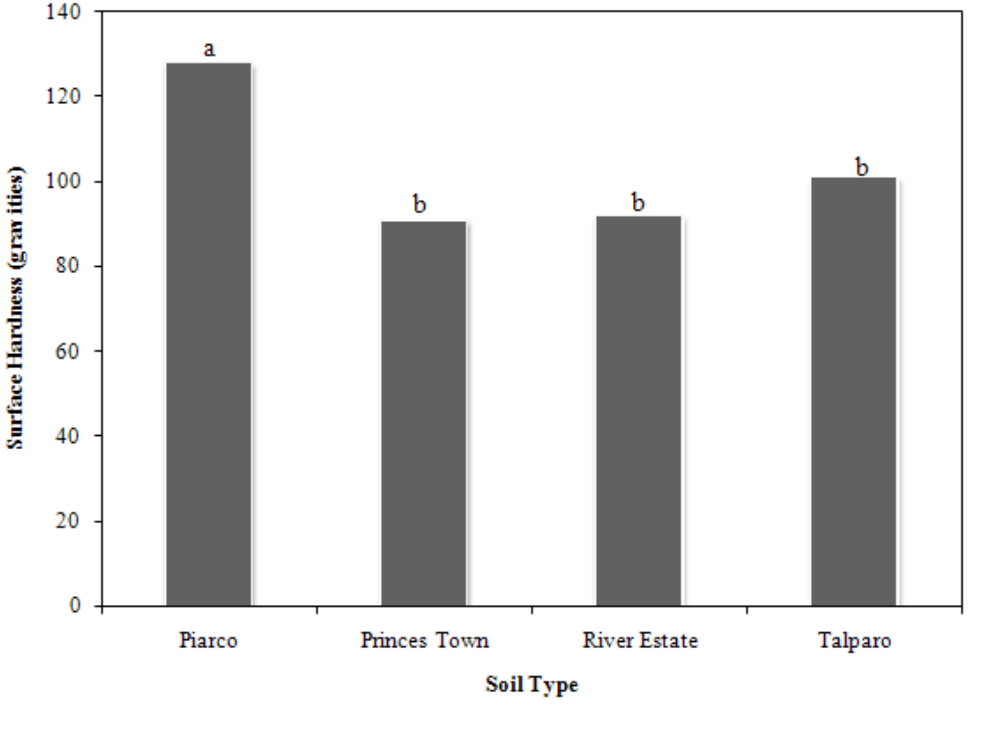
Figure 2. Main effect of soil type on root zone